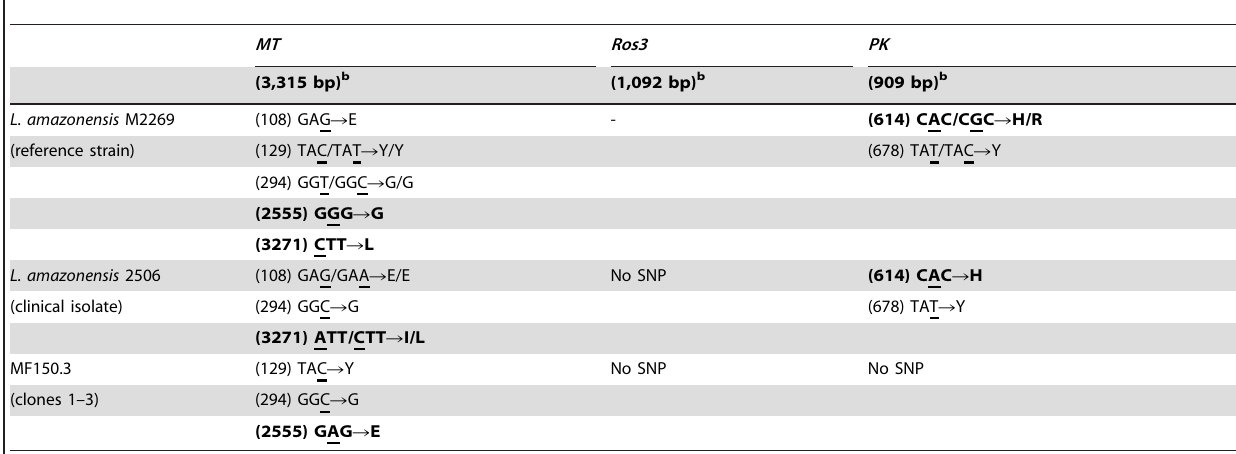
Table 2. Nucleotide polymorphisms in L. amazonensis genes potentially involved in MF susceptibility/resistance in Leishmania a